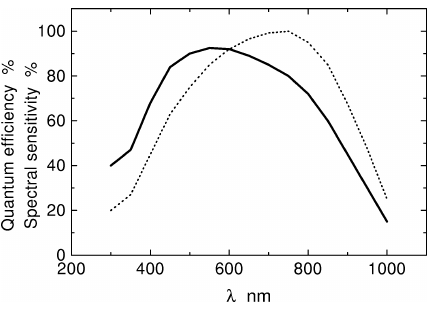
Fig. 1. Quantum efficiency (so- lid) and relative spectral sensitivity (dotted line) of the